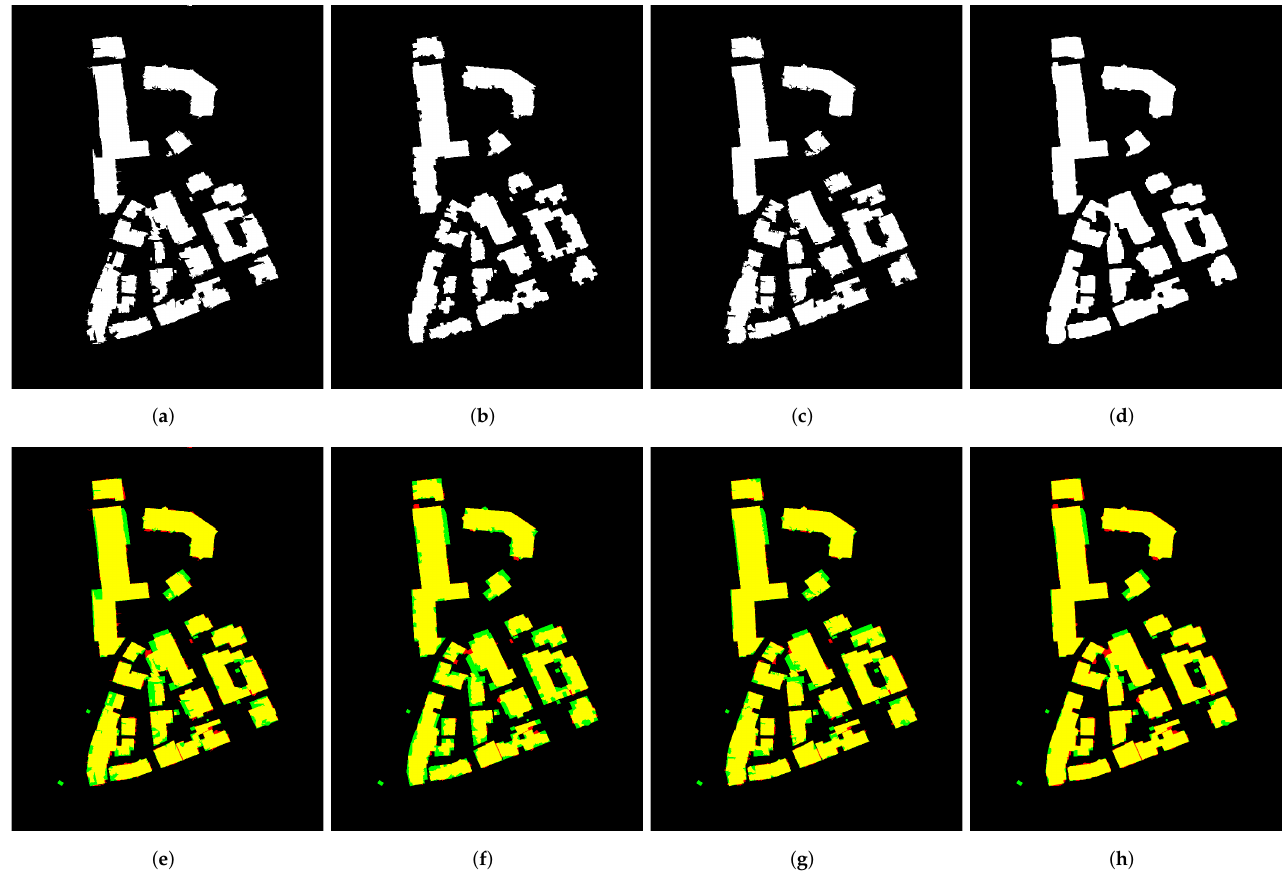
Figure 6. Illustration of our building mask refinement method on real data. ( a , e ): Region-matching result of the GS algorithm. ( b , f ): Region-matching result of the SLIC algorithm. ( c , g ): Region- matching result of the ERS algorithm. ( d , h ): Union of the above three region-matching results that has undergone postprocessing. In ( e – h ), the region-matching results are overlaid with the ground truth, with yellow regions denoting correct detection, red regions denoting false detection (overdetection), and green regions denoting missing detection